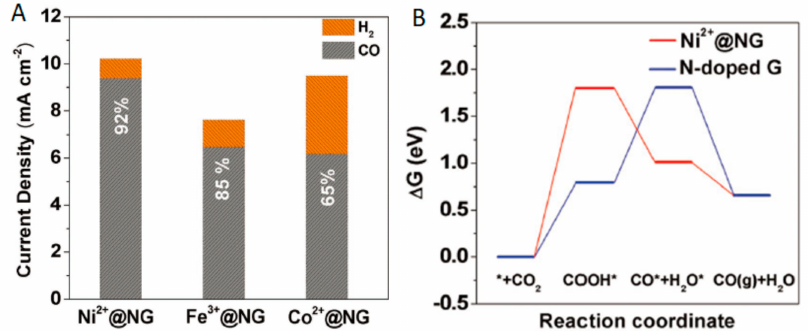
Figure 5. ( A ) The CO 2 performance for various transition metal ions restrained on N-graphene and ( B ) a free energy diagram showing the formation of CO via electrocatalytic CO 2 reduction. Reprinted with permission from [88].